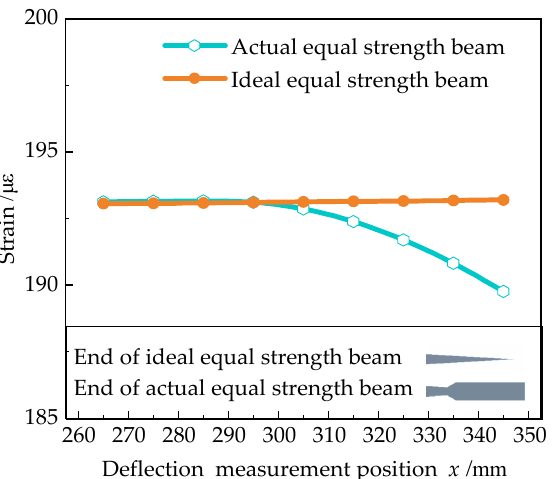
Figure 8. Comparison of calculated strain values at the end of an ideal and actual equal strength beam. According to the analysis in this section, the measurement position offset error + ∆ ε p will make the calculated strain value larger, and the end measurement error − ∆ ε r will make the calculated strain value smaller. Therefore, if the deflectometer is fixed at the end of the equal strength beam for measurement, there will be an optimum deflection measurement position. Thus, the strain measurement error is minimal with the condition of |+ ∆ ε p | = | − ∆ ε r |.